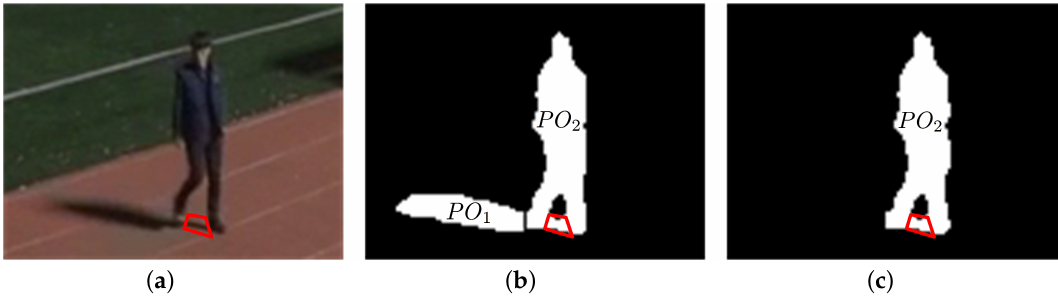
Figure 12. Shadow removal result 1 for a foreground object (120 × 90 pixels from sequence S3):